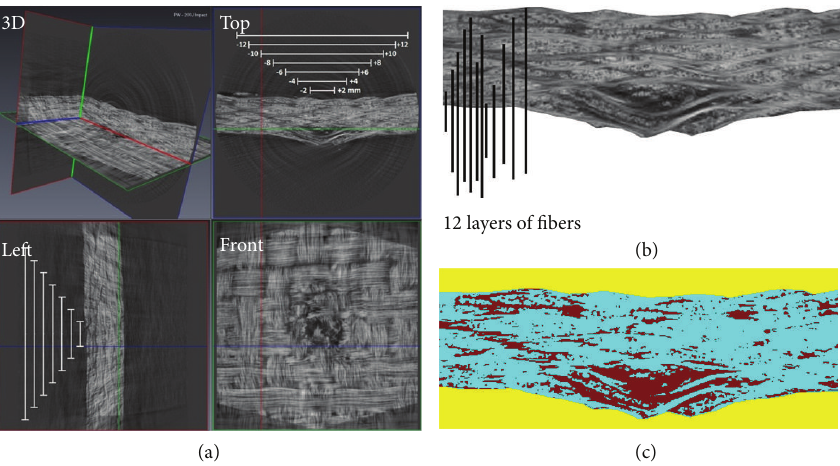
Figure 9: (a) XMT image of the impacted PW laminate (top view at the impact center, left view at 10mm from the impact center, and front view close to the rear side of impact), (b) enlarged top view within a cropped window of 25 mm × 10mm, and (c) the processed image of top view at the impact center (for subsequent damage quantification purposes).